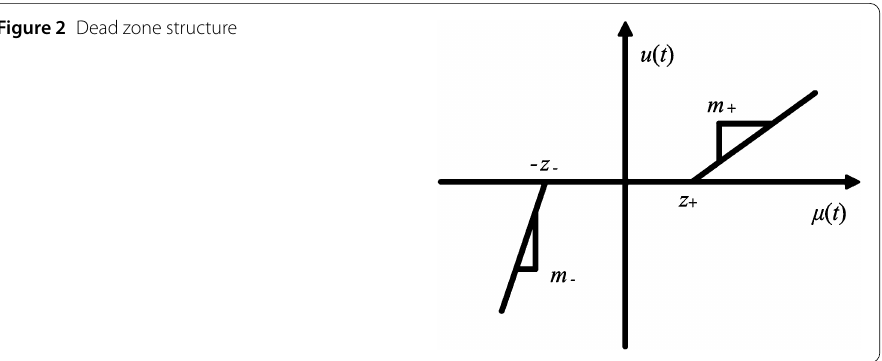
Figure 2 Dead zone